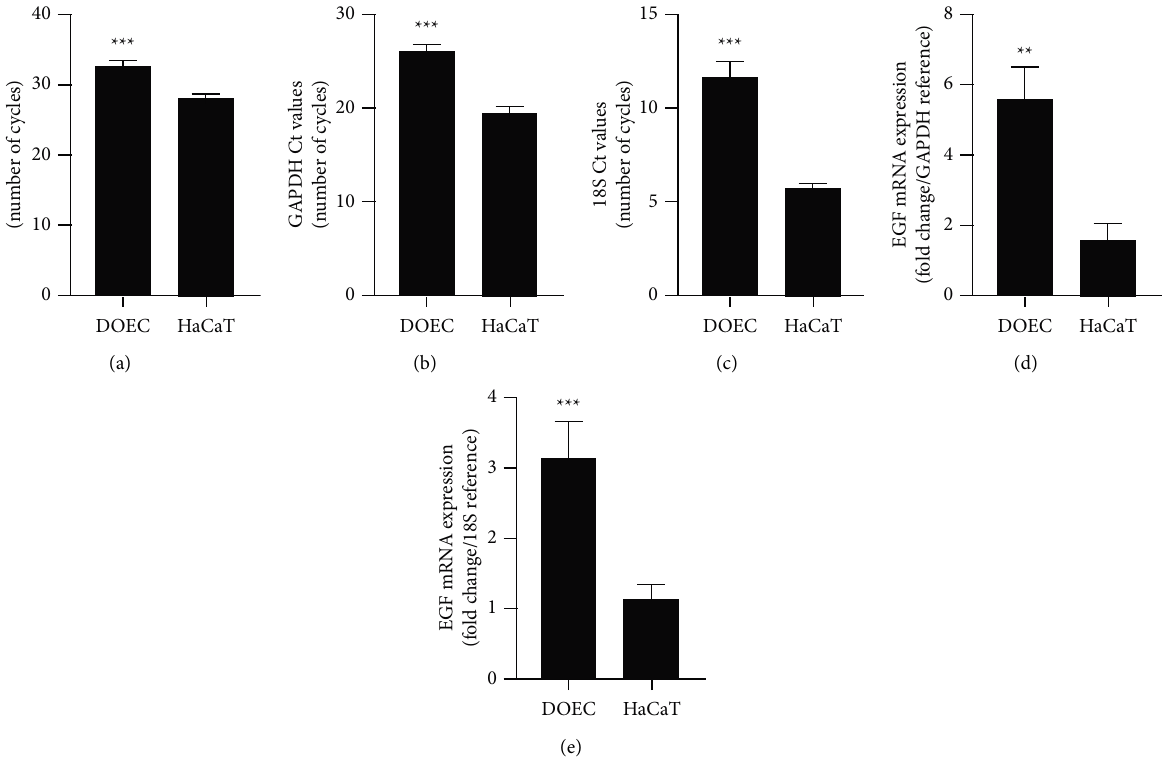
Figure 5: DOECs express the EGF gene as shown by qPCR analysis. (a–e) EGF transcript is detected in DOECs isolated from all 4 volunteers included in the study by qPCR analysis. DOECs have higher Ct values for the EGF (a), the GAPDH (b), and the 18S (c) genes compared to HaCaTcells. Note that a high Ct value represents low gene activity and vice versa . Calculation of EGF gene expression by the delta-delta Ct method and the Pfaf equation with, respectively, GAPDH and 18S as reference genes shows that relative EGF gene expression is higher in DOECs than in HaCaTcells (d, e). Each sample was analyzed in duplicate. DOECs were isolated from all 4 individuals included in the study. Values are presented as means ± SEM for three experiments. Statistical signifcance was calculated by Student’s two-tailed t test for single comparisons between the two groups (DOECs vs . HaCaT cells) as appropriate. ∗∗ represents P < 0 . 01, and ∗∗∗ represents P < 0 .